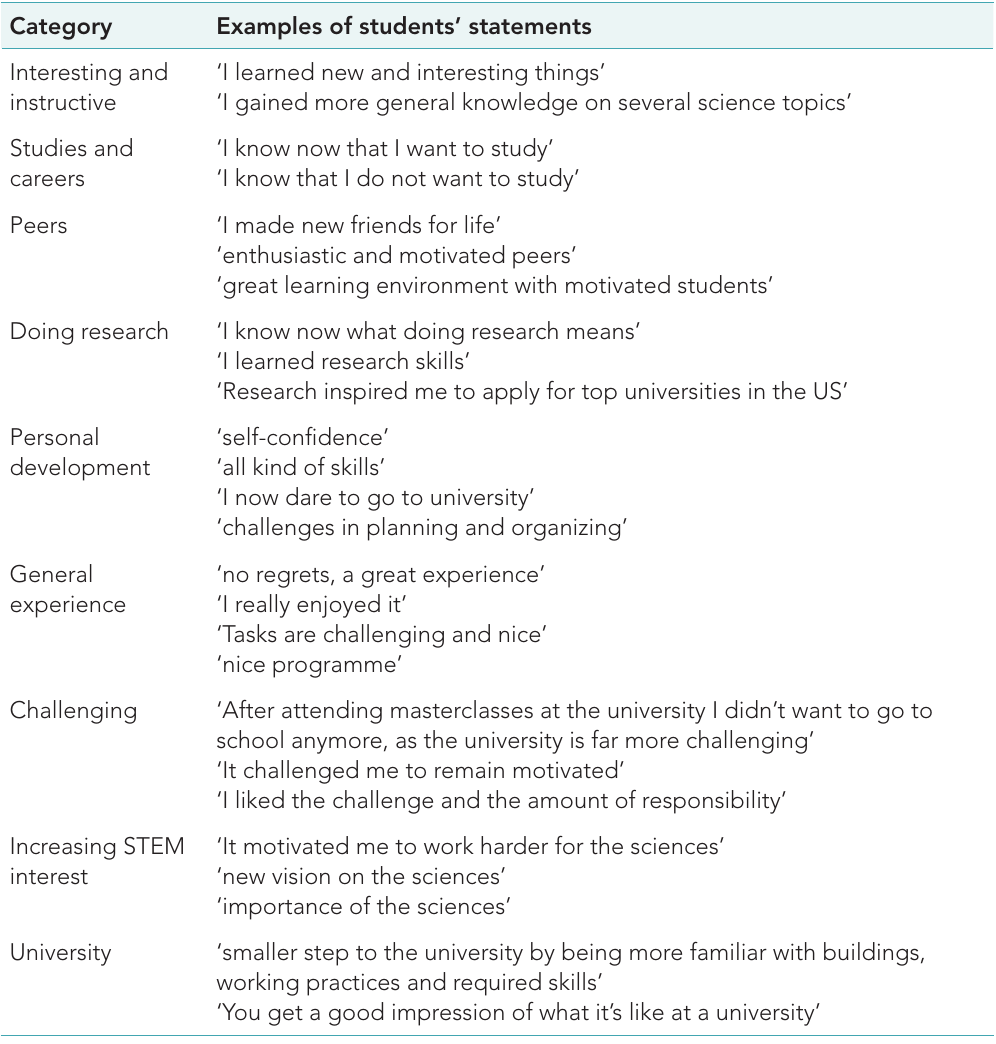
Table 5b: Examples of students’ experiences, based on open questions after UTA